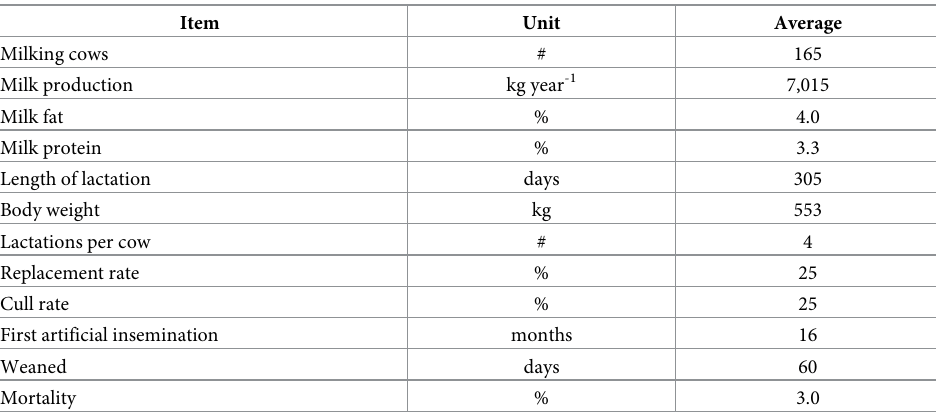
Table 1. Descriptive characteristics of the